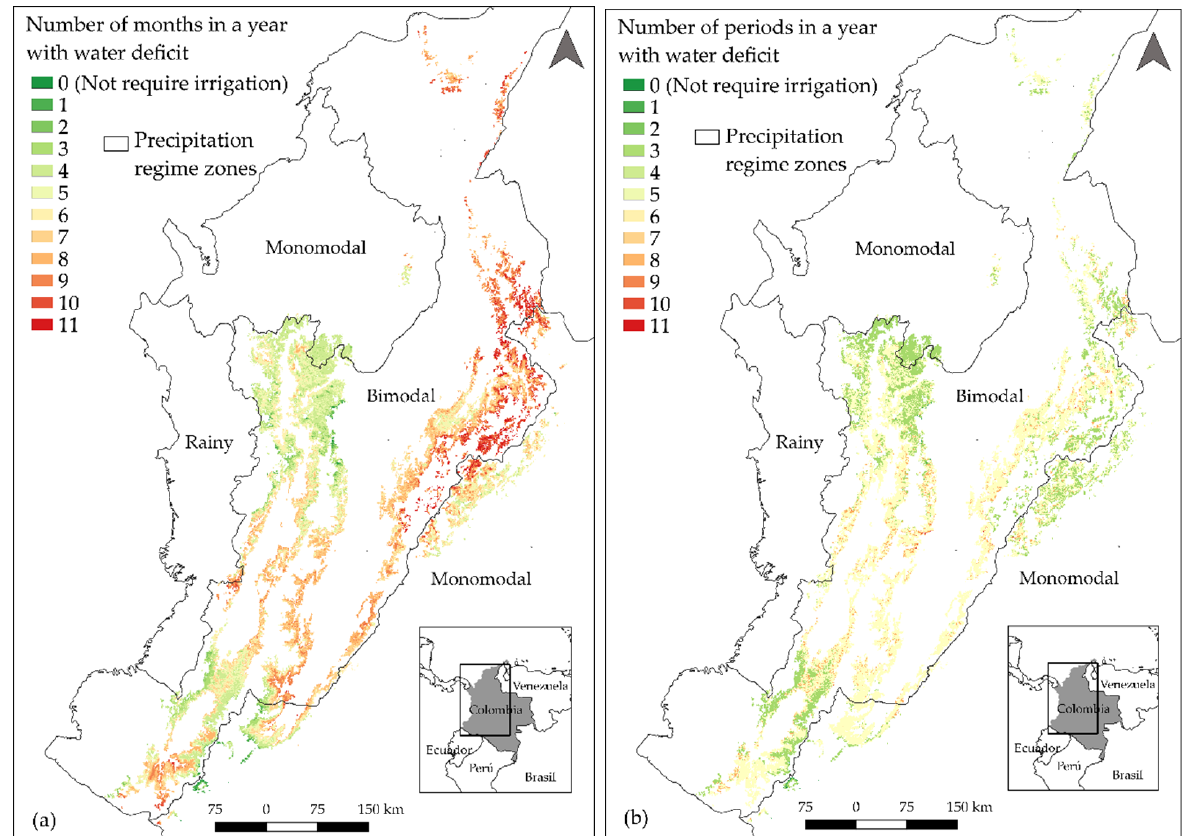
Figure 5. Spatiotemporal distribution of water deficit a year in PPA (potential production area in Colombia) represented with a pixel size of 1 km 2 . ( a ) Number of months in water deficit; ( b ) number of periods in water deficit.